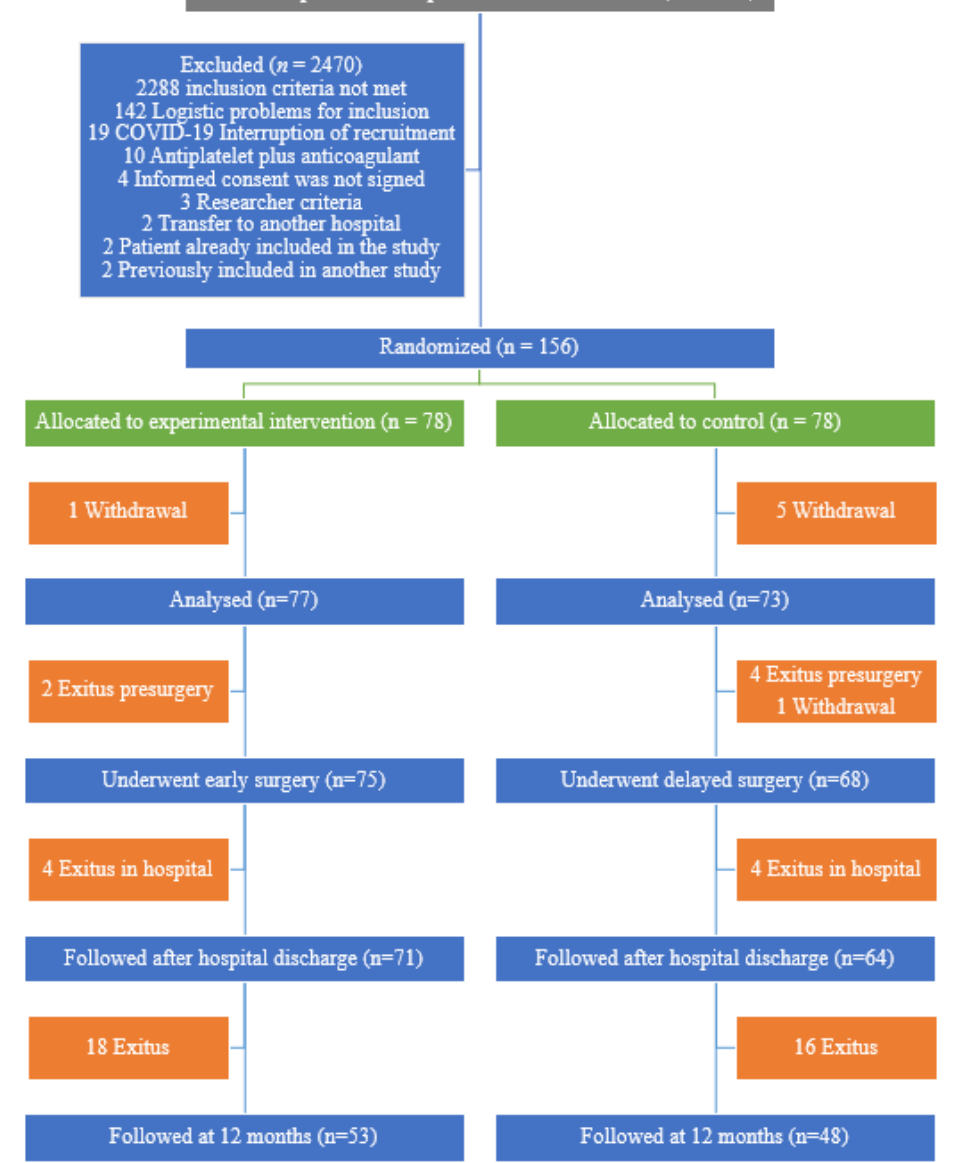
Figure 1. Selection of patients included in the study. Table 1. Characteristics of the study population randomized and did not withdraw their consent before surgery.